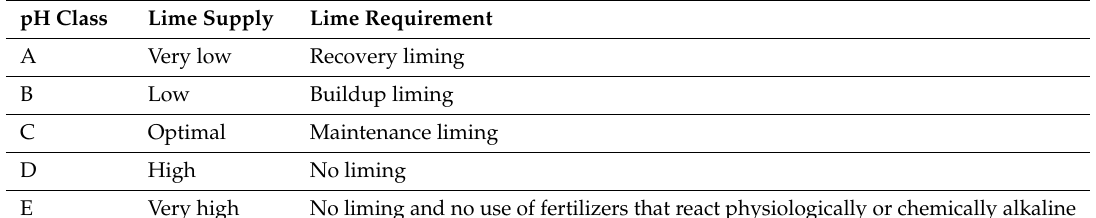
Table 1. Soil pH and the lime requirement classes from the Association of German Agricultural Investigation and Research Institutions (VDLUFA) guidelines valid for Germany